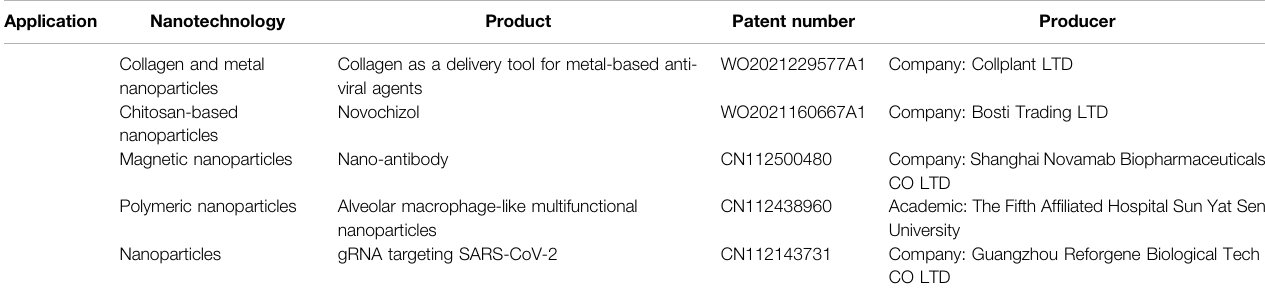
TABLE 1 | ( Continued ) Patents related to the applications of nanobiotechnologies for COVID-19 prevention, vaccines, diagnosis, and treatments. Data from Tavares et al. (2022) and from a query on VaxPal and ESPACENET websites carried out on April